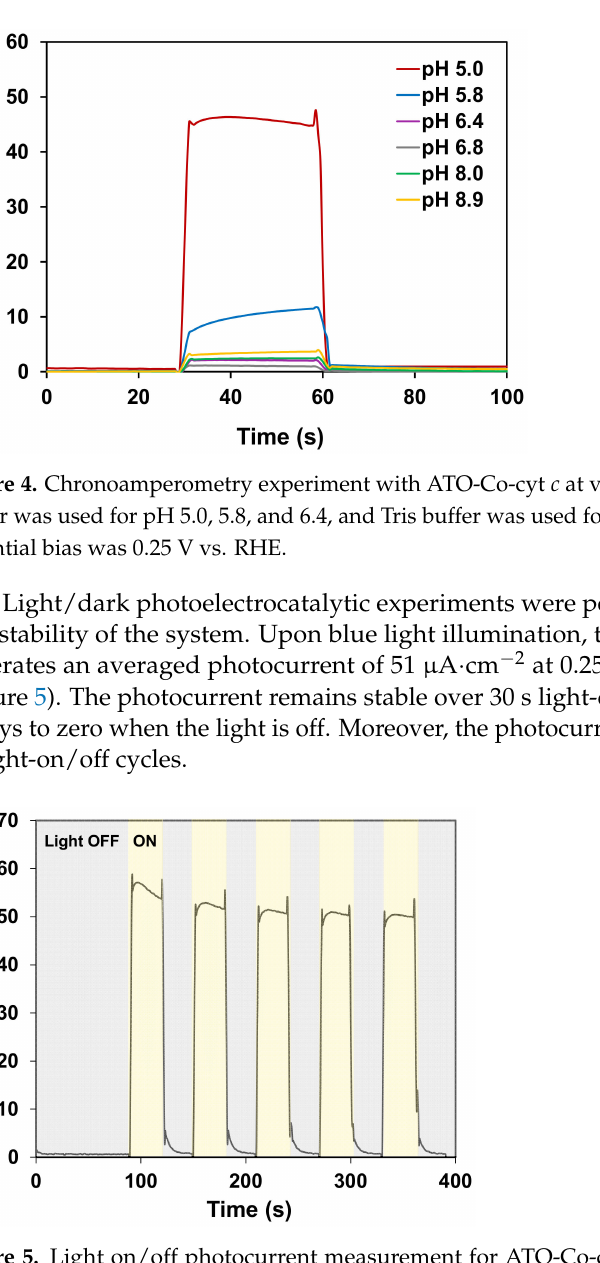
Figure 5. Light on/off photocurrent measurement for ATO-Co-cyt c . The data were collected in 100 mM citrate buffer, 1 M KNO 3 , pH 5.0. The applied potential bias was 0.25 V vs. RHE. The irradiation was performed with a blue light for 30 s at each